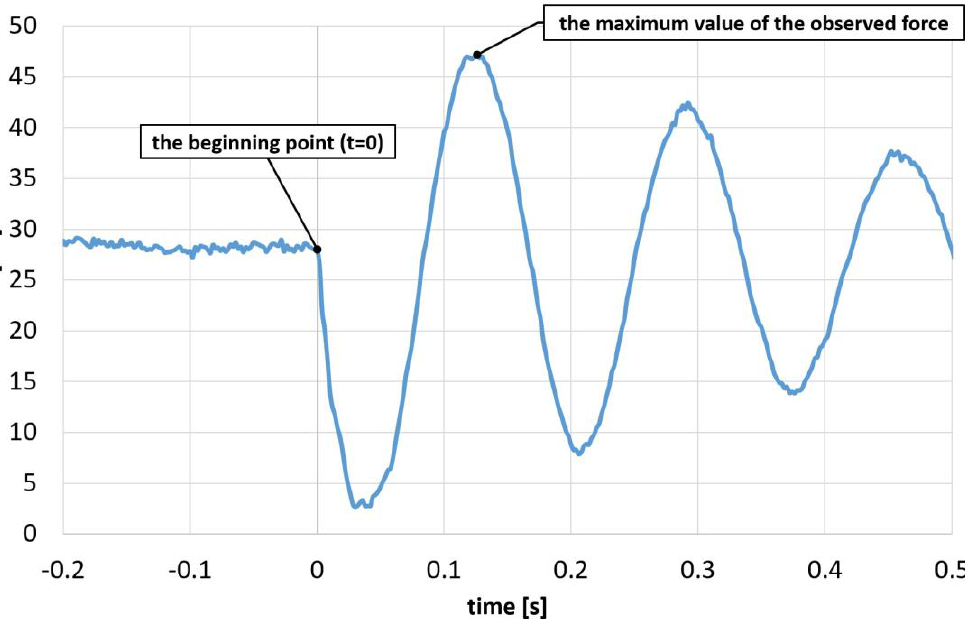
Figure 5. Representative curve of force changes recorded on the measurement rod of the cylinder with the indicated point marking the beginning of the analysis (t = 0).